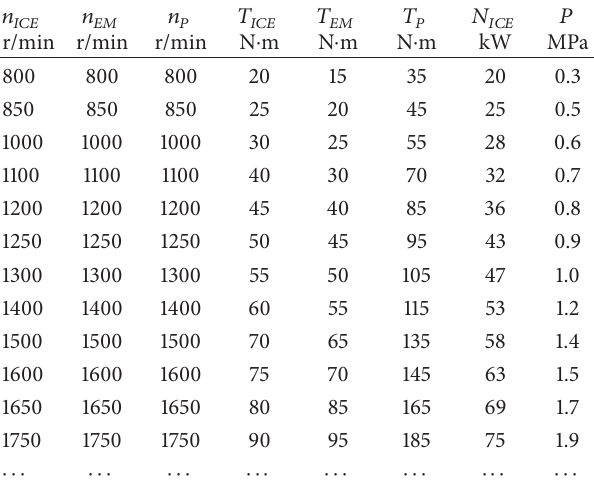
Table 1: Data sample of performance prediction for the hydraulic excavator.